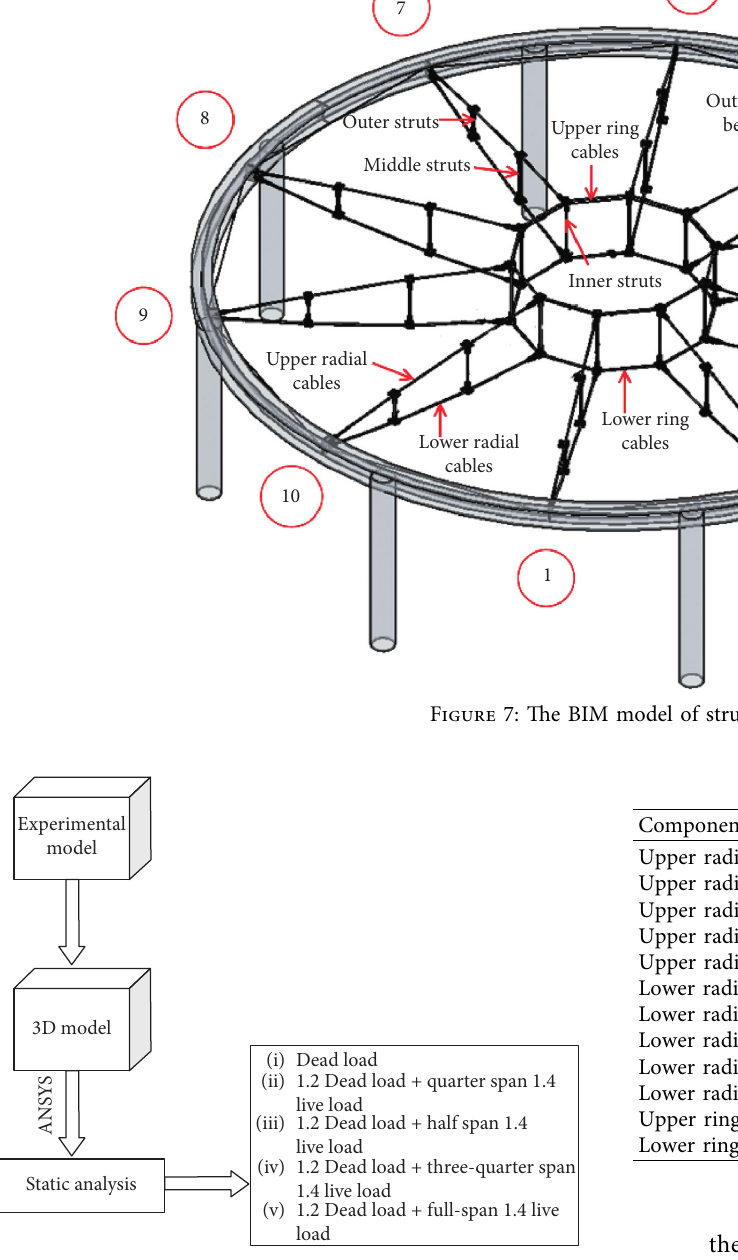
Figure 8: Physical model building process.